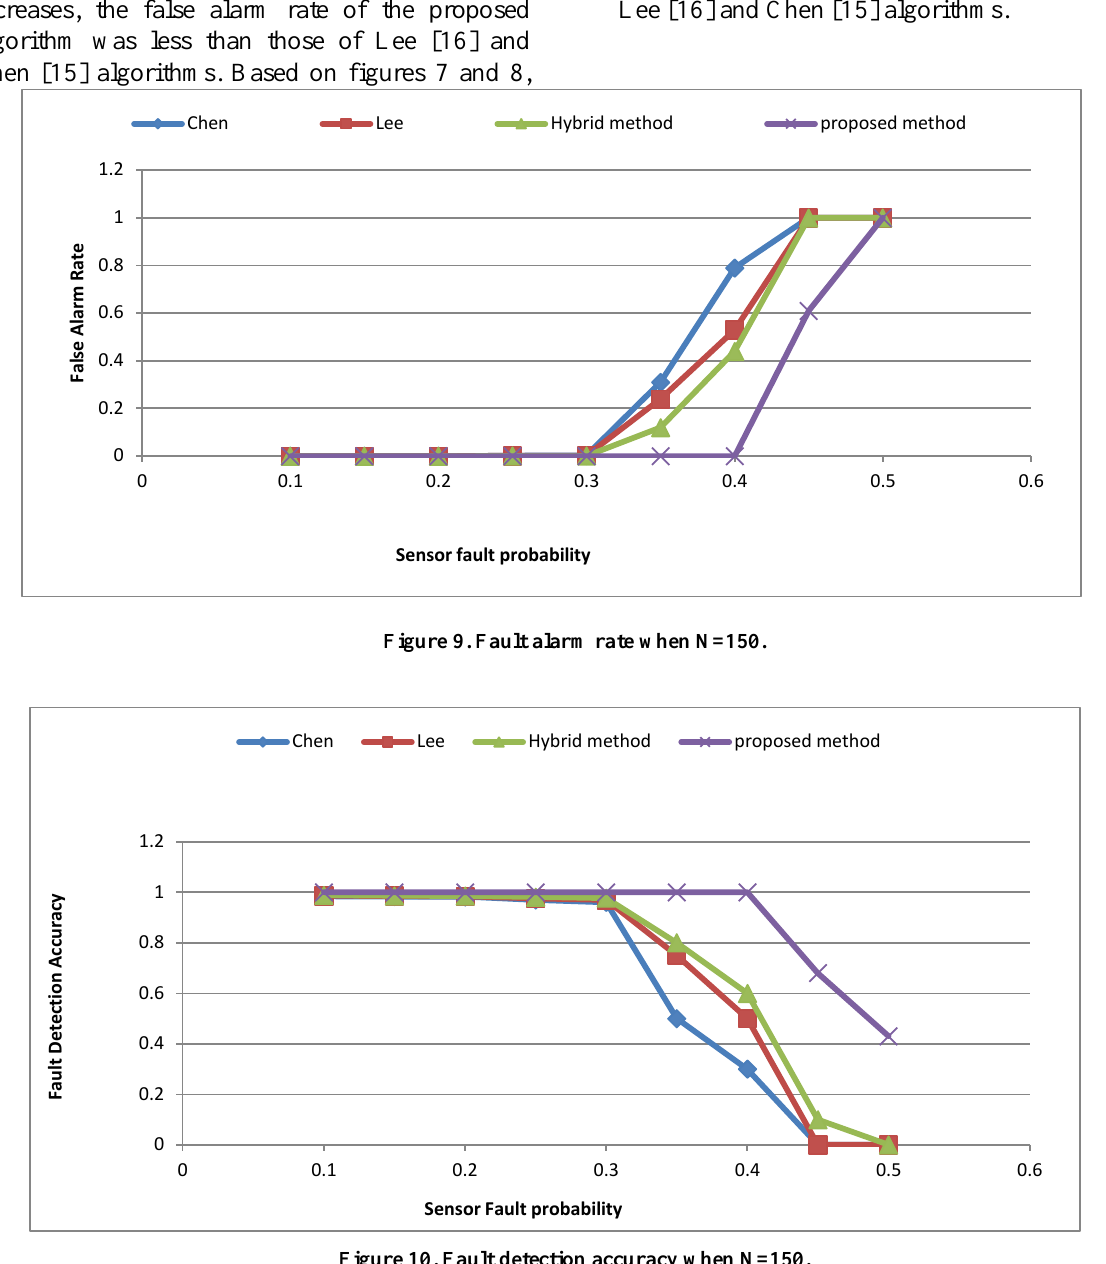
Figure 10. Fault detection accuracy when